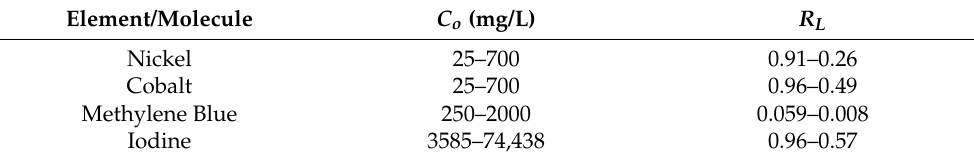
Table 5. Langmuir separation factors.